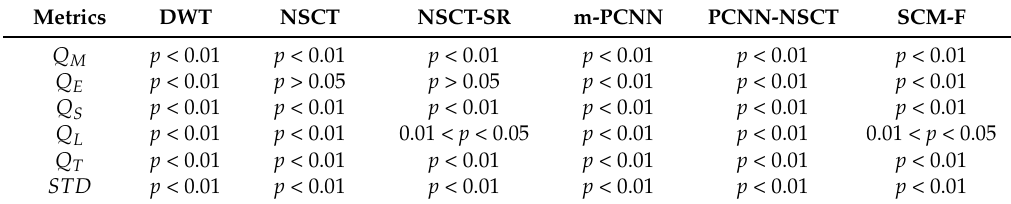
Table 7. Paired t -test results for the compared methods operating on the eight groups of medical